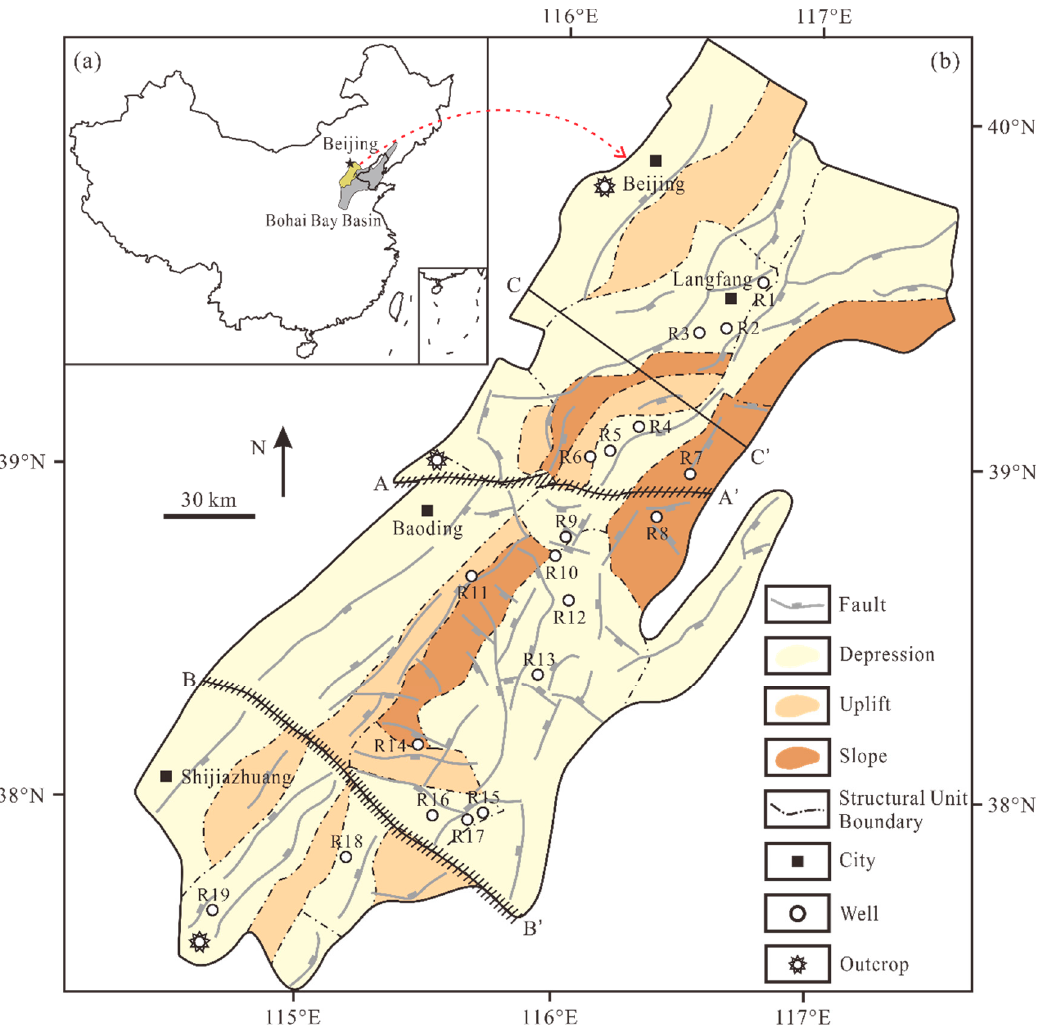
Figure 1. ( a ) Location of the Jizhong Sub-Basin in the Bohai Bay Basin in China (modified from Zhao et al., 2015) [9]. ( b ) Map showing the faults, structural units, transfer zones, wells, and outcrops in the Jizhong Sub-Basin (modified from Chang et al., 2016) [35]. The fault data was modified from the Huabei Oilfield database. A-A’ is the Xushui-Anxin-Wenan transfer zone, and B-B’ is the Wuji-Shenxian-Hengshui transfer zone. C-C’ represents the position of the cross-section in Figure 2.